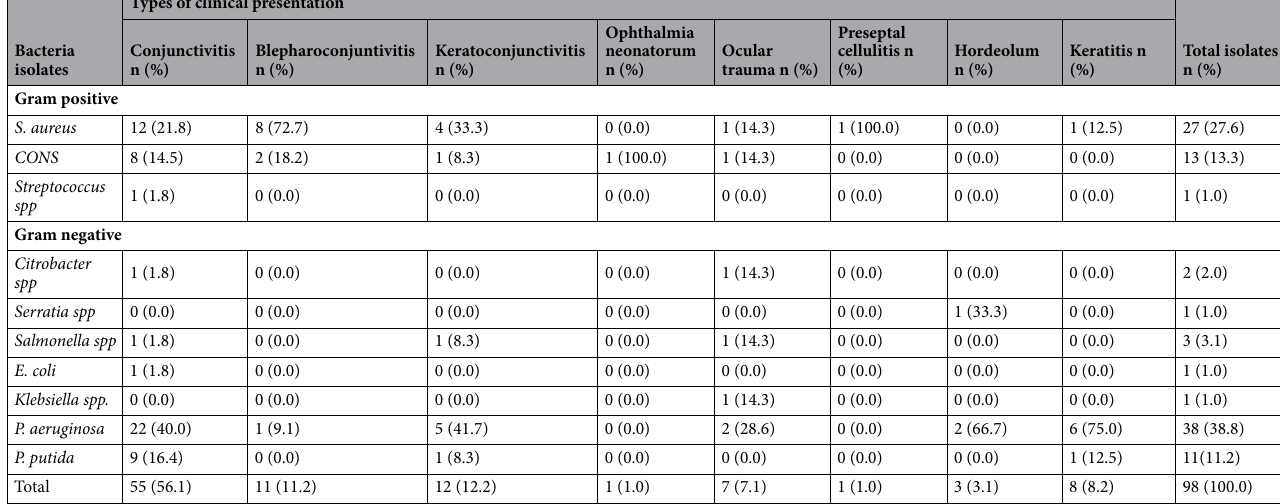
Table 4. Distribution of bacteria isolates across different clinical presentations of external ocular and periocular infections in a Ghanaian ophthalmic population. n frequency, % percentage frequency, CONS coagulase-negative staphylococcal